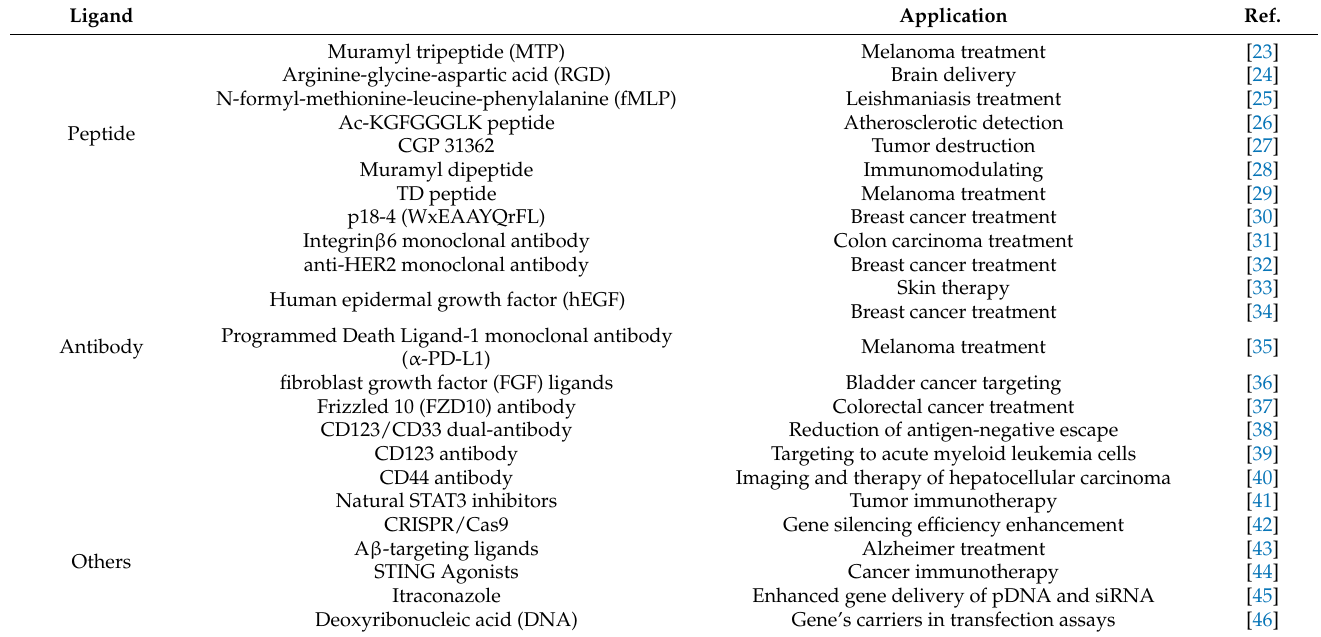
Table 1. Examples of the applications of liposomes with different